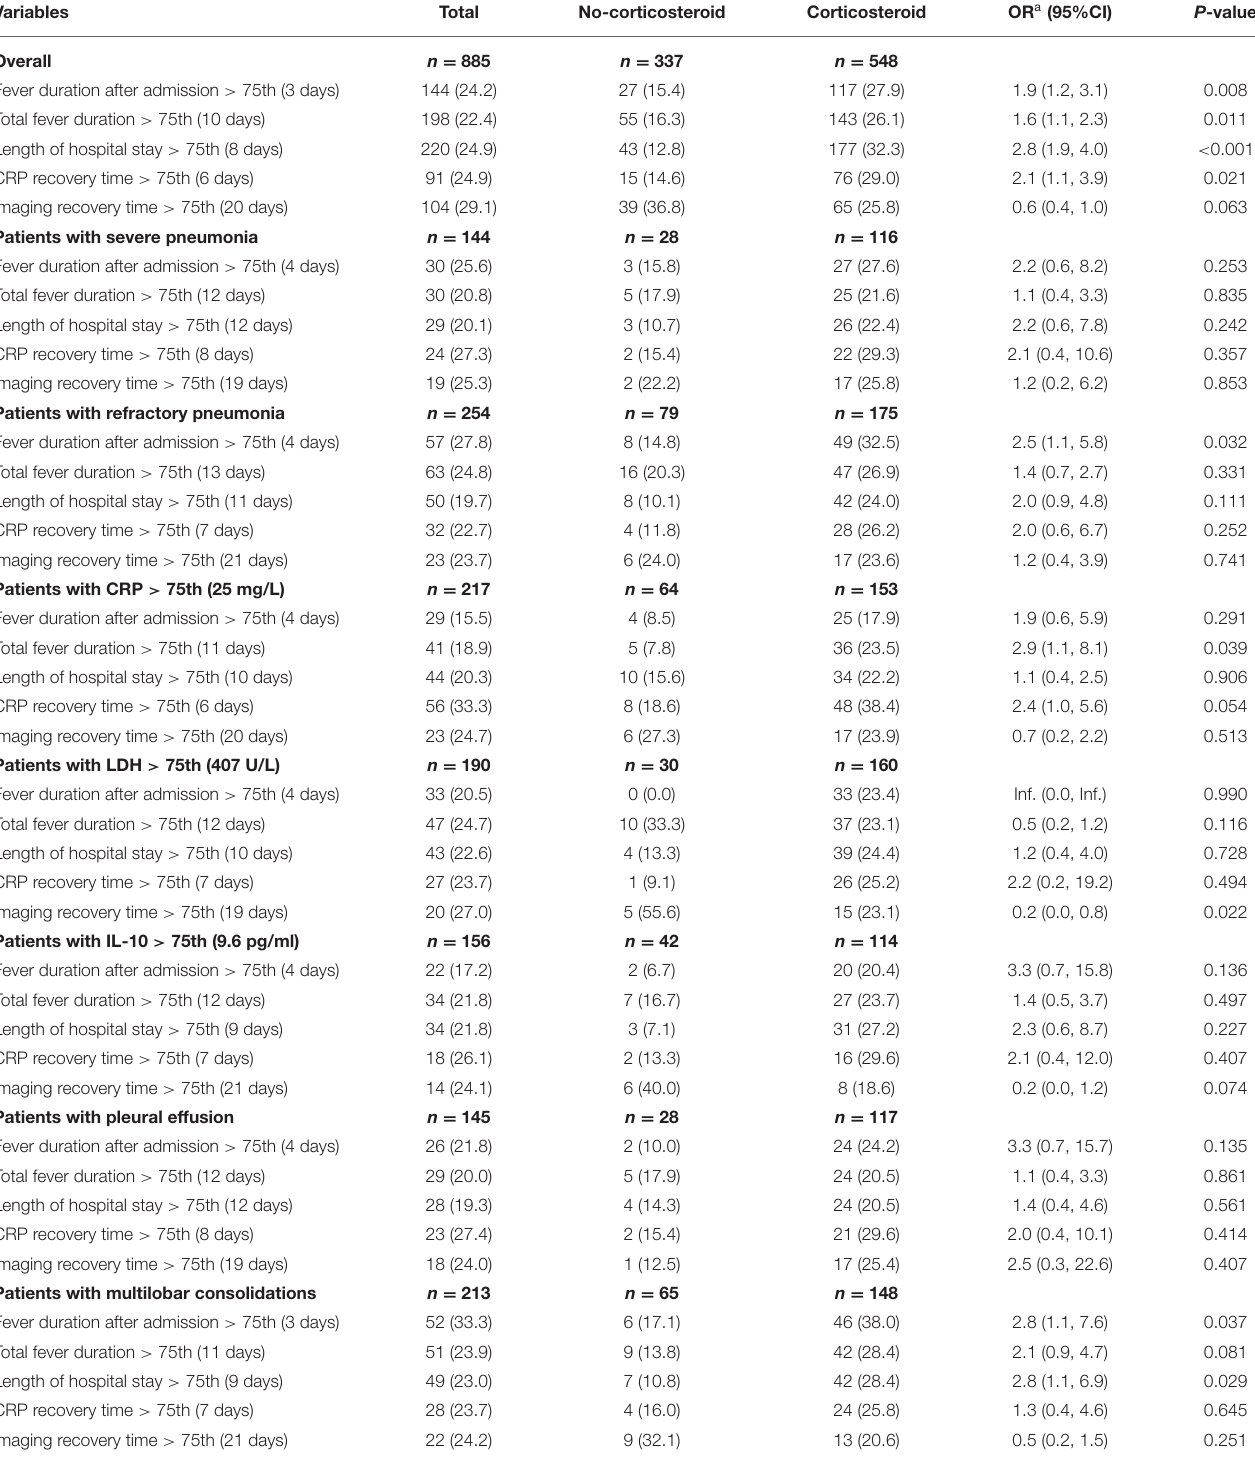
TABLE 2 | Logistic regression analysis for the effects of adjunctive corticosteroid treatment in Mycoplasma pneumoniae pneumonia patients. Variables Total No-corticosteroid Corticosteroid OR a (95%CI) P